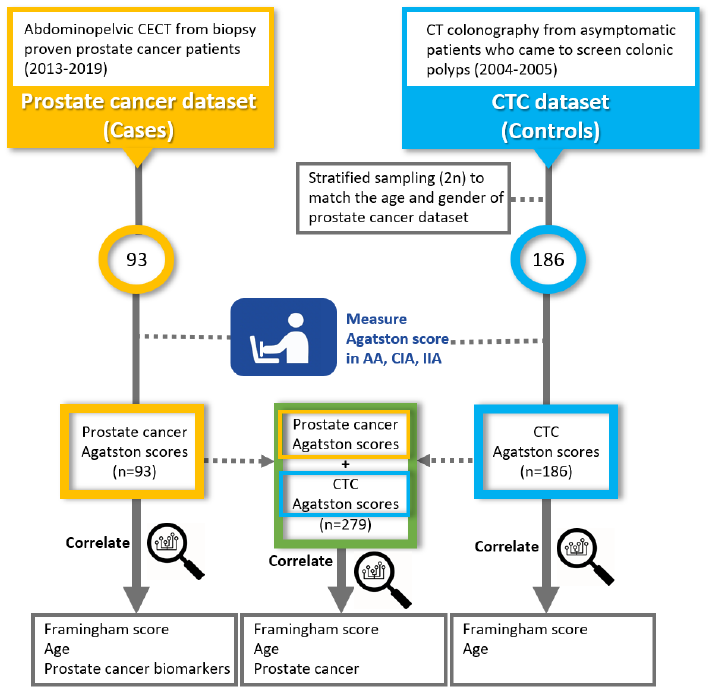
Figure 1. Flow diagram of study outline. Abbreviations: CECT, contrast-enhanced CT; CTC, CT co- lonography; AA, abdominal aorta; CIA, common iliac artery; IIA, internal iliac